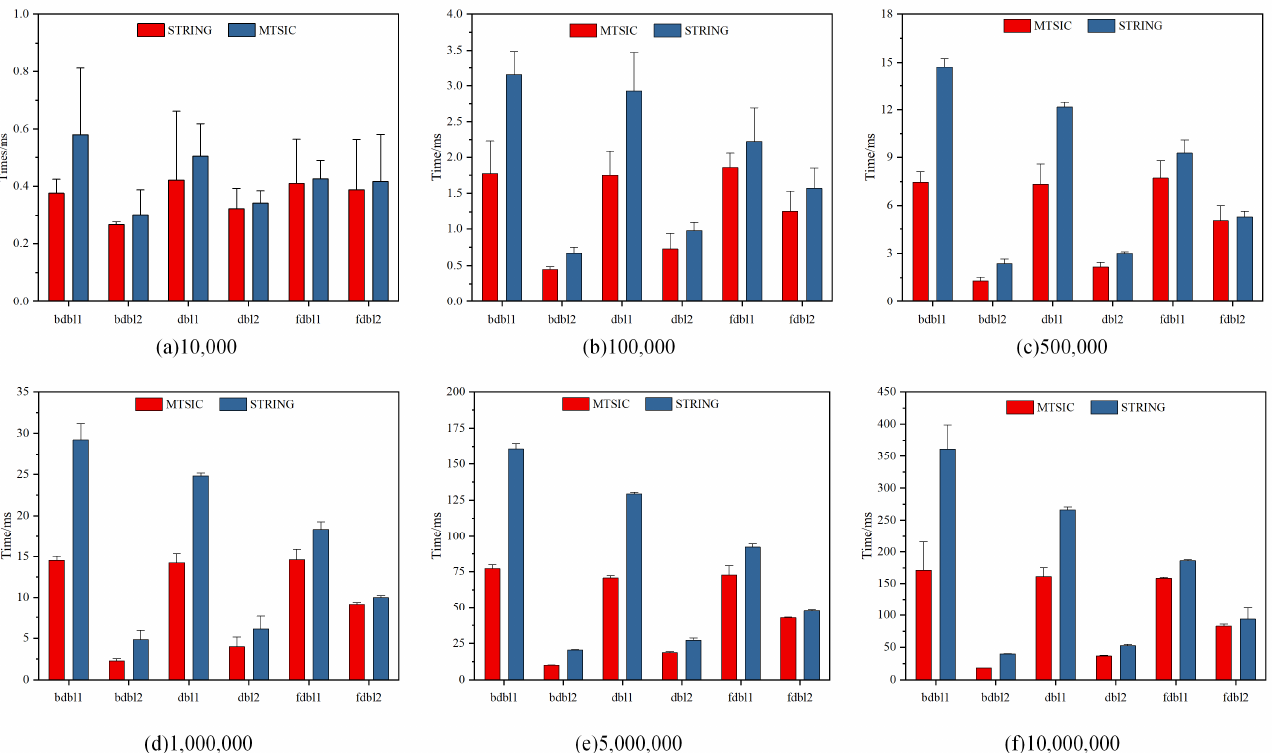
Figure 9. The query time of the two coding methods under different time data (1: “2014–2015”; 2: “15 November 2014–15 February 2015”). The red marks in Figure 9a–e are all lower than the blue marks, so the query time of MTSIC is less than that of string coding. Under the data volume of 10,000, the time-consuming of the string coding was 1.2 ( dbl1 ) times, 1.5 times ( bdbl1 ), 1.1 times ( dbl2 ), and 1.2 times ( bdbl2 ) of MTSIC, respectively. Under the 10,000 data volume